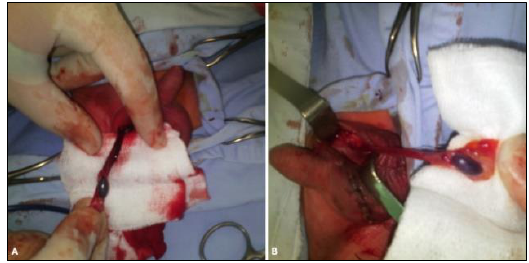
Figure 1: Bilateral perinatal testicular torsion. (A) Right testicle (B) Left